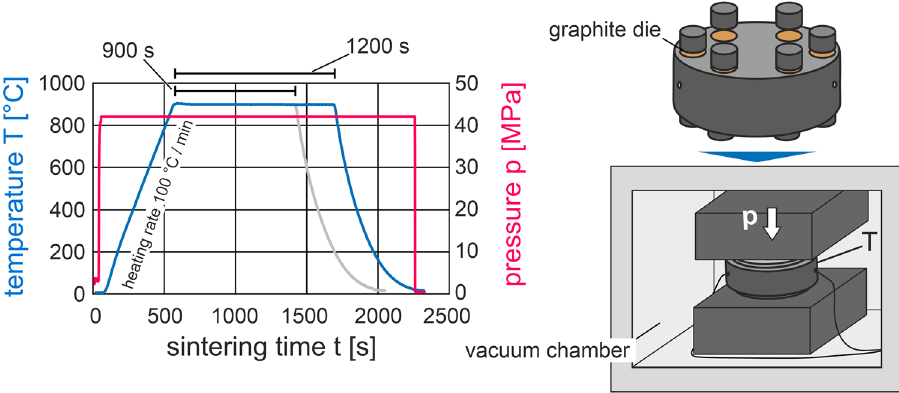
vacuum chamber of the Dr. Fritsch DSP510 sintering press